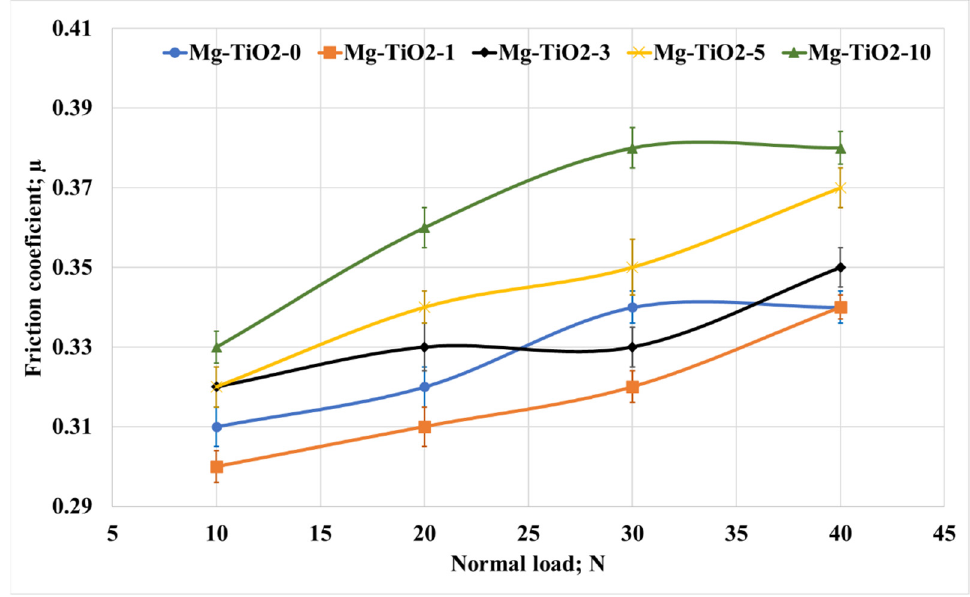
Figure 6. Friction coefficient of Mg/TiO 2 nanocomposites under different normal loads, 900 m.